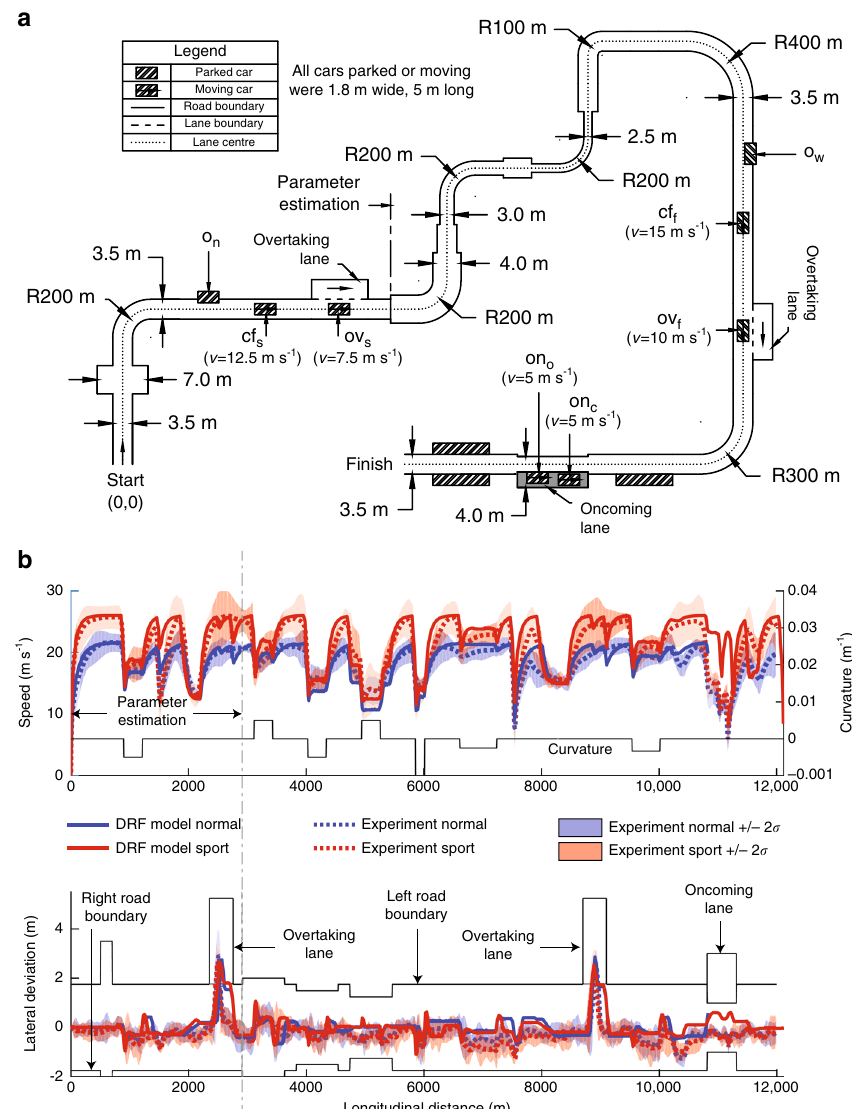
Fig. 3 Track used for testing the driver model. a The track contains four road and three traf fi c scenarios. The four road scenarios are (1) Curve radii: R100m, R200m, R300m and R400m, (2) Lane widths: 2.5, 3.0, 3.5 and 4.0 m, (3) Obstacle avoidance: A car was parked on a 3.5-m wide straight section such that 0.9 or 1.4 m of the car-width encroached on the road to simulate narrow (o n ) and wide (o w ) obstacles, respectively. (4) Roadside furniture: A 200-m long row constituting of 10 cars was placed either outside the left lane boundary (asymmetric) or outside both lane boundaries (symmetric). The three traf fi c scenarios are (1) Car following: Two cars travelling at a constant speeds of 12.5 m s − 1 (cf s ) and 15 m s − 1 (cf f ) along the lane centre on different straight sections were followed. (2) Overtaking: Two cars travelling at constant speed of 7.5 m s − 1 (ov s ) and 10 m s − 1 (ov f ) were overtaken using a 3.5 m overtake lane. (3) Oncoming traf fi c: Two cars travelling at a constant speed of 5 m s − 1 on the 2-m wide oncoming lane, approached the ego car. The fi rst oncoming car drove on the lane centre (on c ). The second car was offset 0.3 towards the ego car. b To identify realistic values for the parameters of the DRF driver model, we replicated the track in a driving simulator and one volunteer drove 10 times ‘ normally ’ (blue) and 10 times in a ‘ sporty manner ’ (red). Speed and lateral deviation from the lane centre are plotted as a function of the distance travelled along the lane centre of the track. The speed and lateral deviation trajectories of the DRF driver model, for the most part, lie within the ± σ limits of the experimental trajectories. The ‘ sport ’ parameter setting consistently drives faster than the ‘ normal ’ setting and in both cases shows similar trends in acceleration braking as shown by the human. The driver model maintains itself within the lane boundaries, while exhibiting satis fi cing (i.e., not always following the lane centre), even in conditions that were not experienced during parameter areas of low cost and hence, can use a larger width of the road Lateral position: SDLP, which represents the swerving without steering corrections (exhibit satis fi cing), resulting in behaviour of a car, is reported to increase with lane width, in a higher SDLP. simulator study by Godley et al. 37 . They examined the SDLPs of Speed: It is reported that the speed at which drivers negotiate participants on three different lane widths (2.5, 3.0, 3.6 m) (Fig. 4- roads increases as the lane width increases, in simulator 37,41 – 43 2b). Similar results are reported in other simulator 38,39 and on- and on-road studies 40,44 . The DRF model also showed a similar road studies 40 which are coherent with the predictions of the DRF model (Fig. 4-2a). On a wider road, the DRF model has wider increase in speed with lane width (Fig. 4-2c) and is compared to